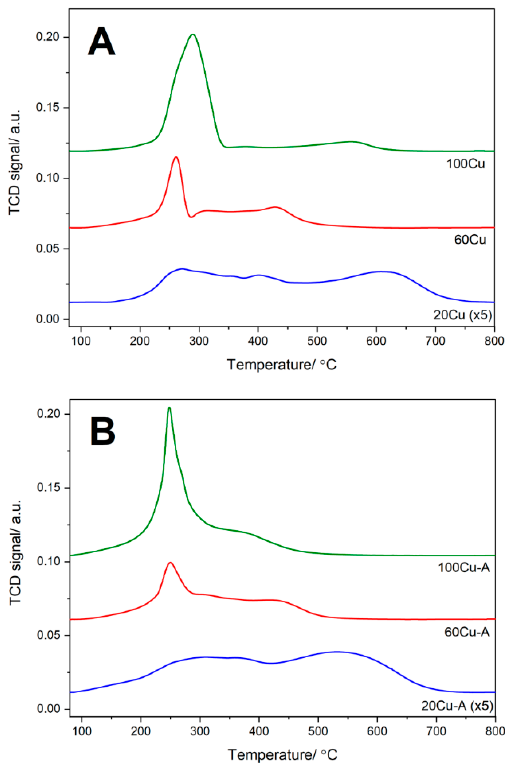
Figure 8. Results of H 2 -TPR studies of the Al-S-MCM-41 sample modified with copper by TIE ( A ) and TIE-NH 3 ( B ) methods.